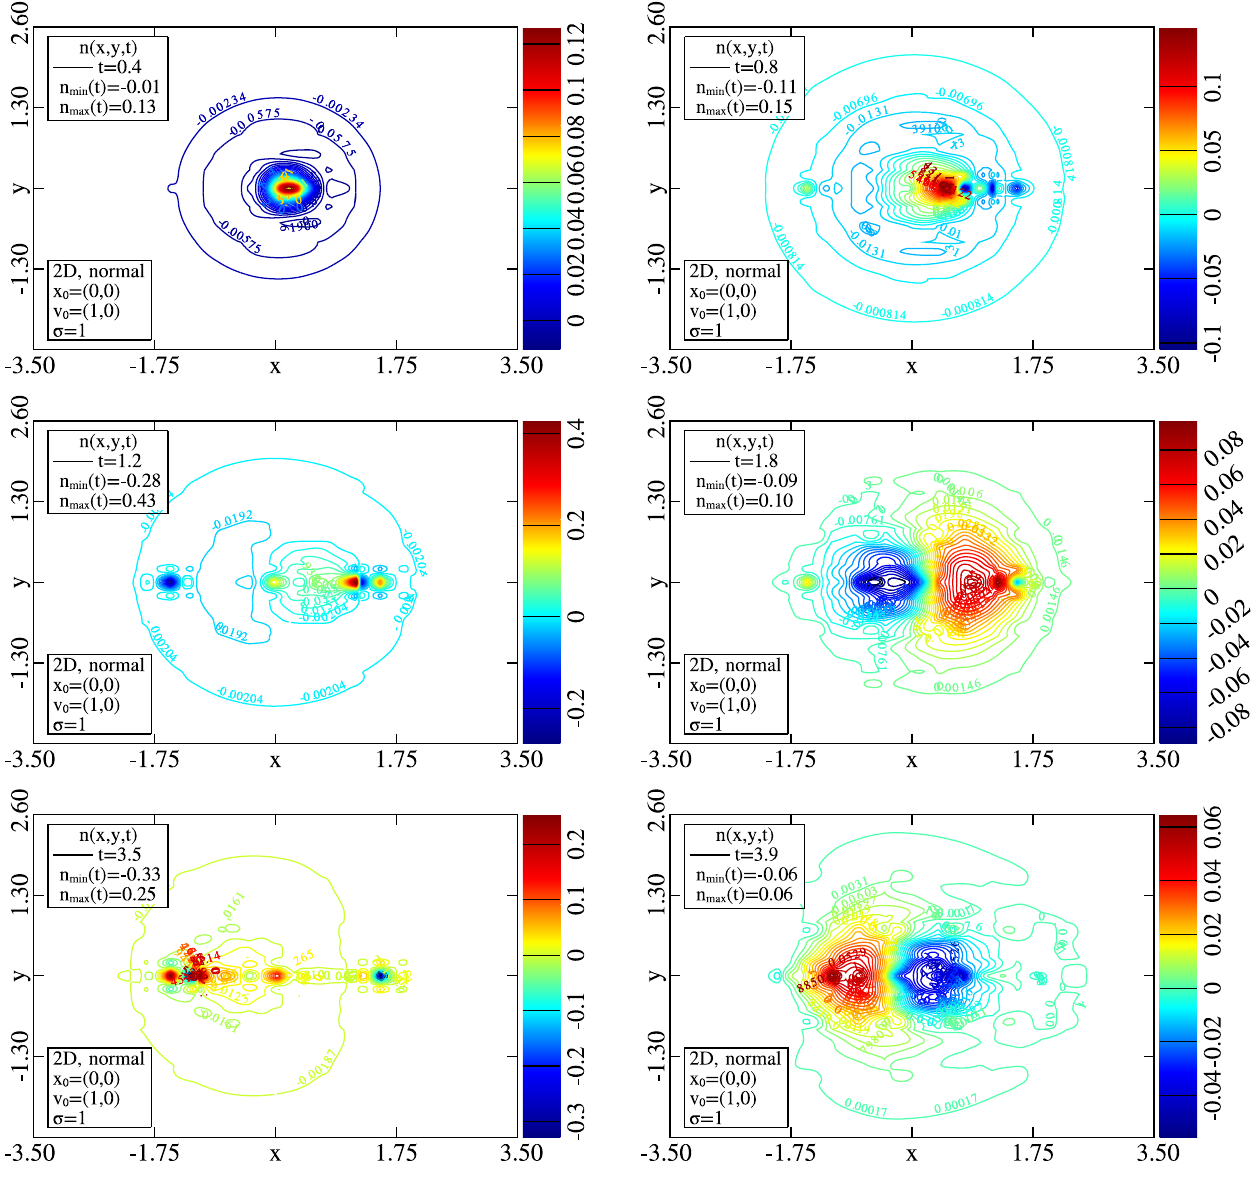
FIG. 7. Dynamics of the density n ð ~ x ; t Þ for the 2D plasma with normal spatial and velocity distributions for different values of time; the external charge starts moving from ~ x 0 ¼ ð 0 . 0 ; 0 . 0 Þ with velocity ~ v 0 ¼ ð 1 . 0 ; 0 . 0 Þ ; each plot has its own color